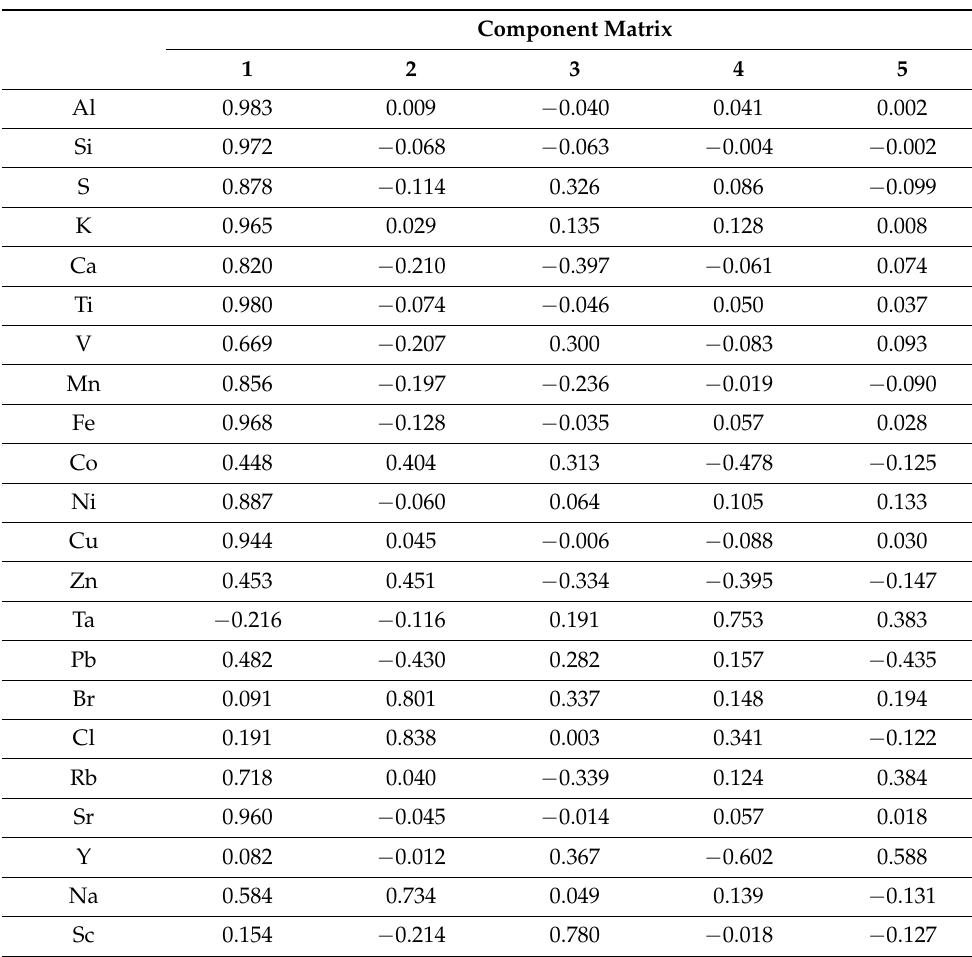
Table 6. Five components matrices for the quantified elements in PM 2.5 collected from historical Jeddah